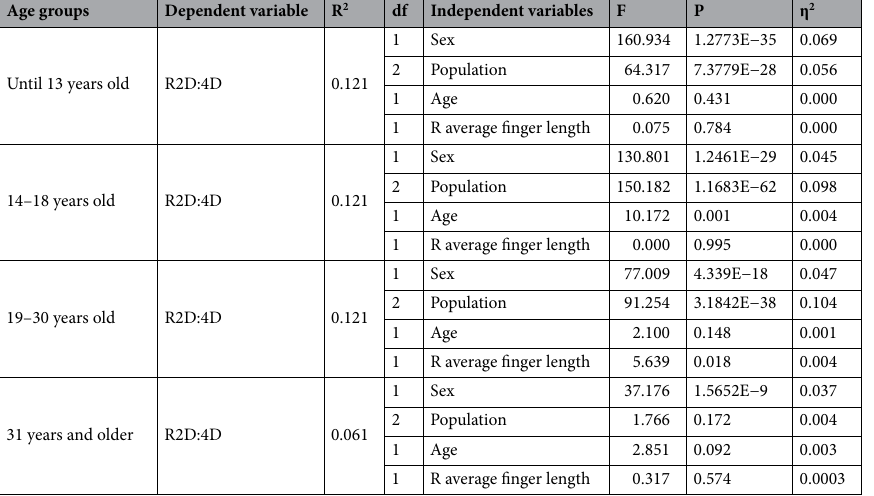
Table 4. Four-factor (sex, population, age, average finger length for the right hand) ANCOVA analyses for outcome variables the right 2D:4D ratio in prepubertal, pubertal, young and older adults age cohorts. R 2